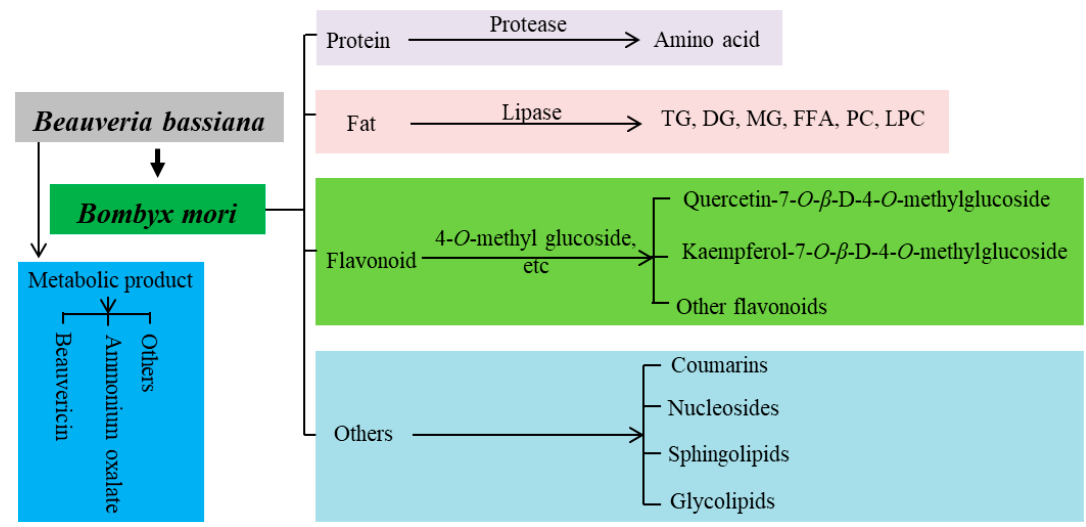
Figure 4. Changes in chemical constituents of B. batryticatus during the stiff stage.